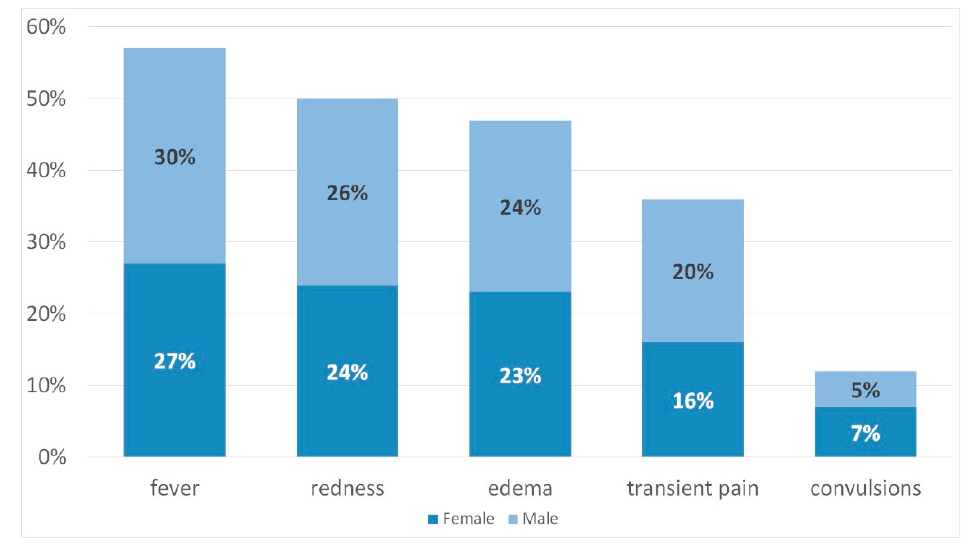
Figure 4. Parents’ knowledge of possible vaccine adverse event.